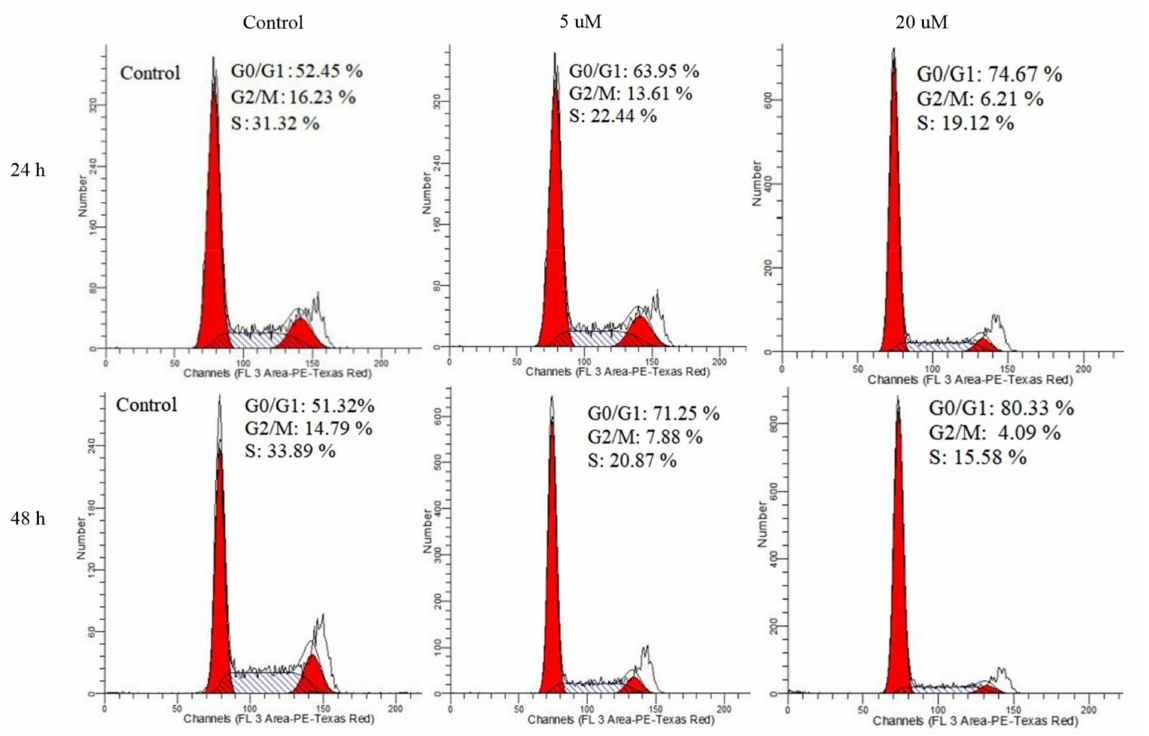
Figure 10. HepG2 cell cycle distributions after exposure to 5 µ M, as well as 20 µ M complex 1 for 24 h and 48